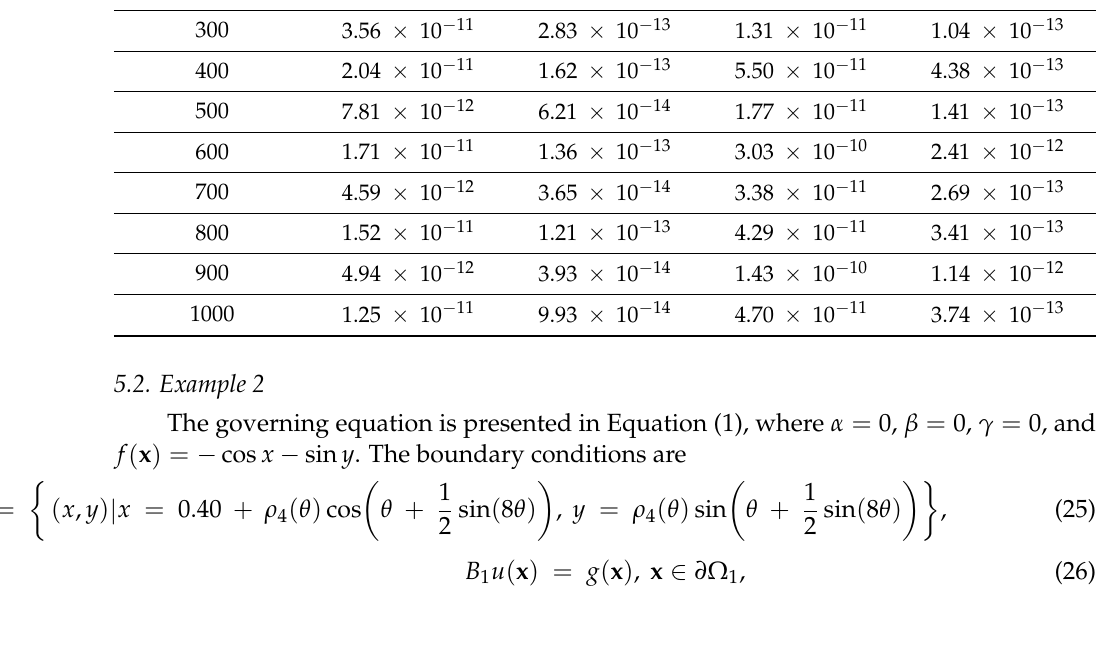
Table 2. Errors of the proposed method with various wave numbers. Wave